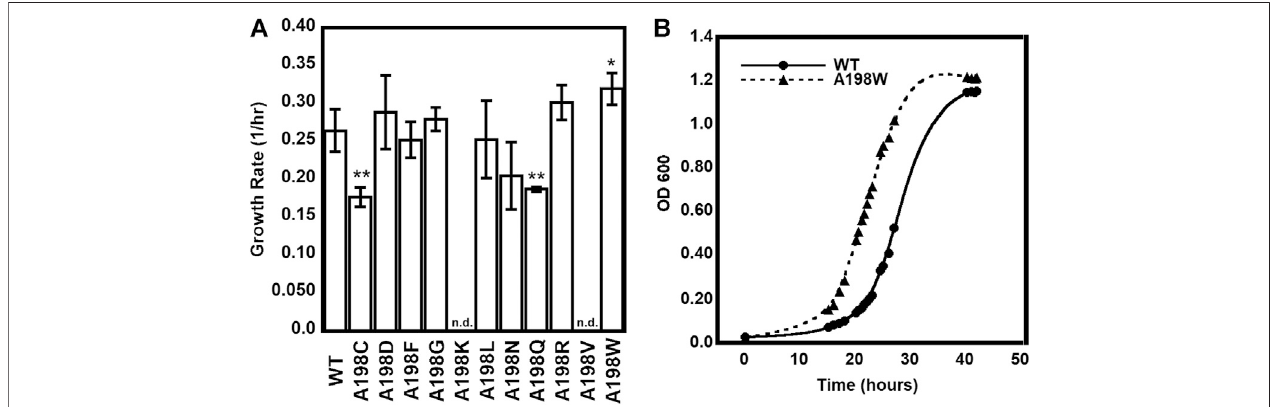
FIGURE2| GrowthcomplementationassaysoftrpA-deleted Escherichiacoli K12cells. (A) Tryptophan-auxotrophic E.coli cellswerecomplementedwithplasmid expressing α TSWTorA198variants,andgrowthratesdetermined.Asterisksindicatethatthegrowthratefor E.coli expressingtheA198variantwasstatisticallydifferent than the growth rate for E. coli expressing WT α TS, according to p value (0.01 < * < 0.05; 0.001 < ** < 0.01; n (cid:1) 3). n. d. not determined because E. coli cells expressing the A198K and A198V variants did not grow in the absence of tryptophan (B) Representative growth curves demonstrating the A198W variant ’ s increased growth rate.